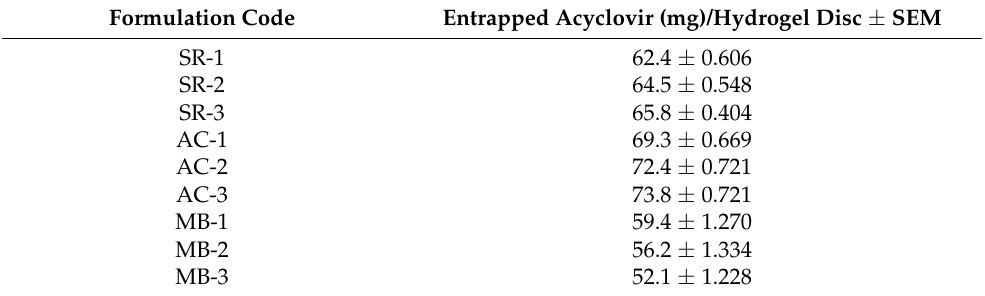
Table 1. The entrapment efficiency of the developed formulations.